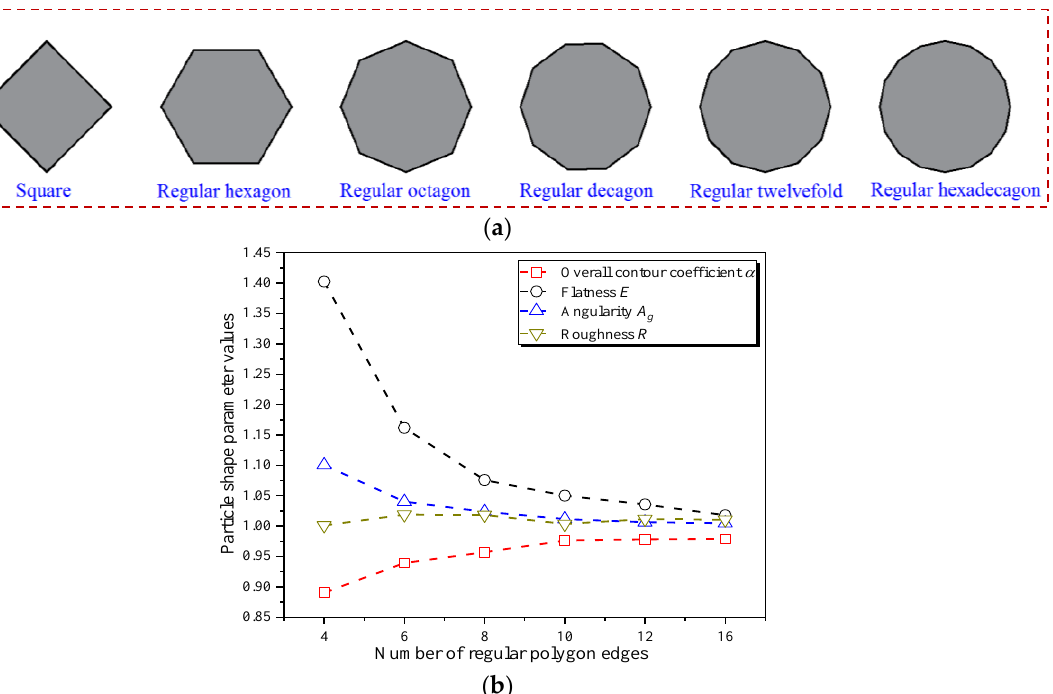
Figure 14. Comparison of shape parameters for regular polygons: ( a ) schematic diagram of regular polygons, ( b ) variation of particle shape parameter value with the number of regular polygon edges.